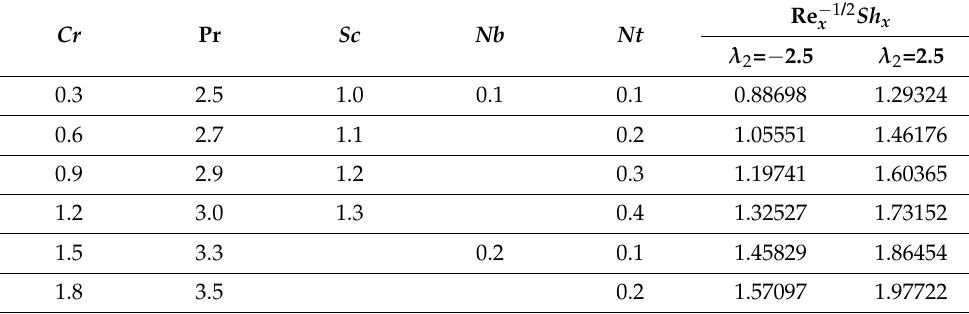
Table 5. Numerical outcomes f Re − 1/2 x Sh x for numerous values of Cr ,Pr, Sc